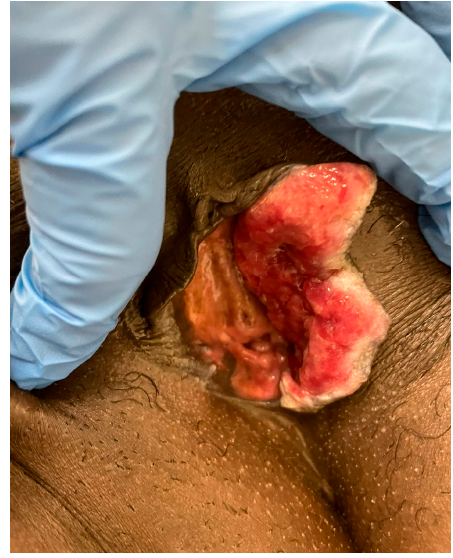
Figure 2. After 1 cycle of